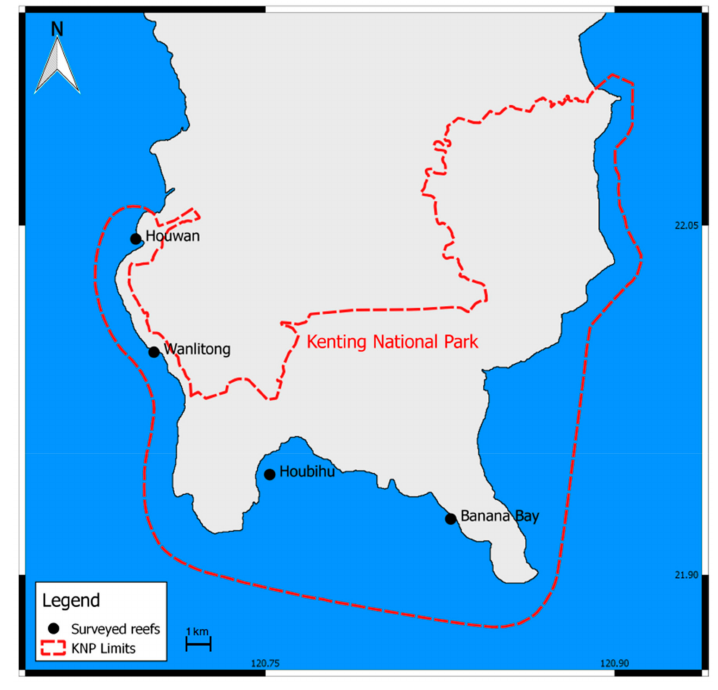
Figure 1. The Kenting National Park.